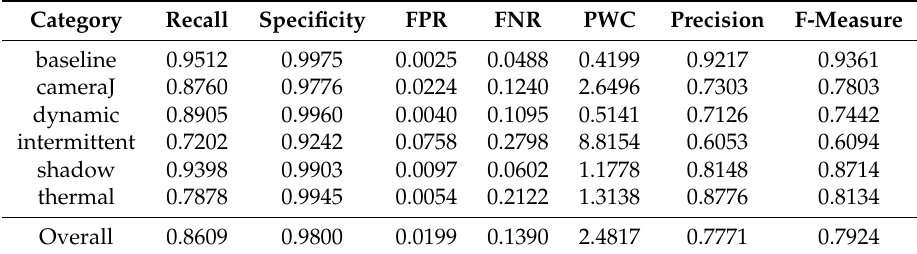
Table 3. Complete results obtained with the proposed method on the CDnet2012 dataset. FPR: false positive rate; FNR: false negative rate; PWC: percentage of wrong classifications Category Recall Specificity FPR FNR PWC Precision